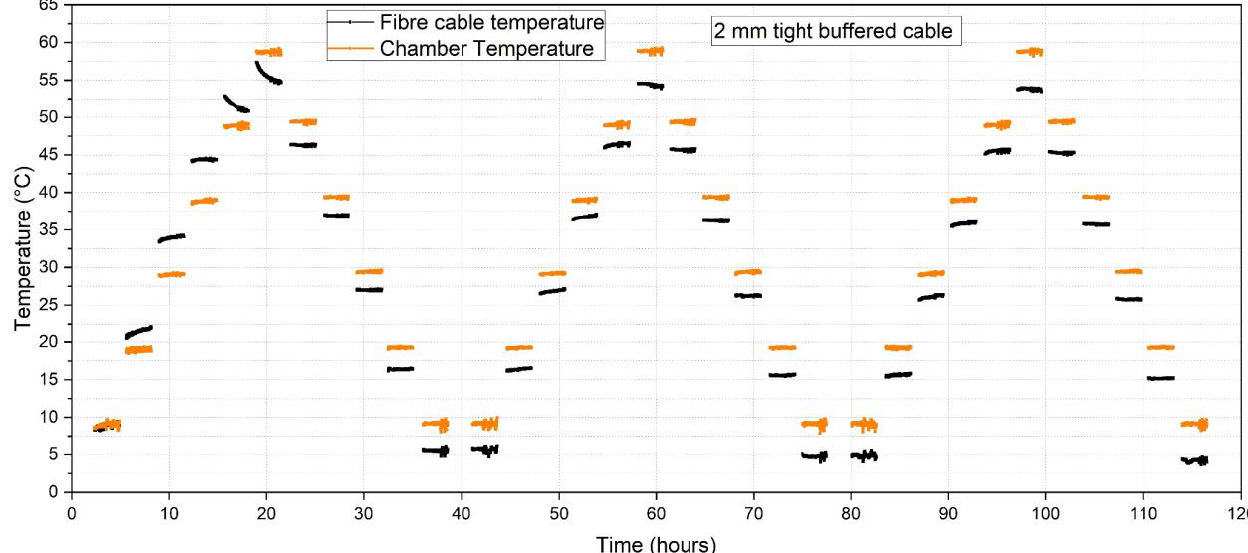
Figure 16. Deviation from the fibre optic cable (black line) to the chamber temperature (orange line).